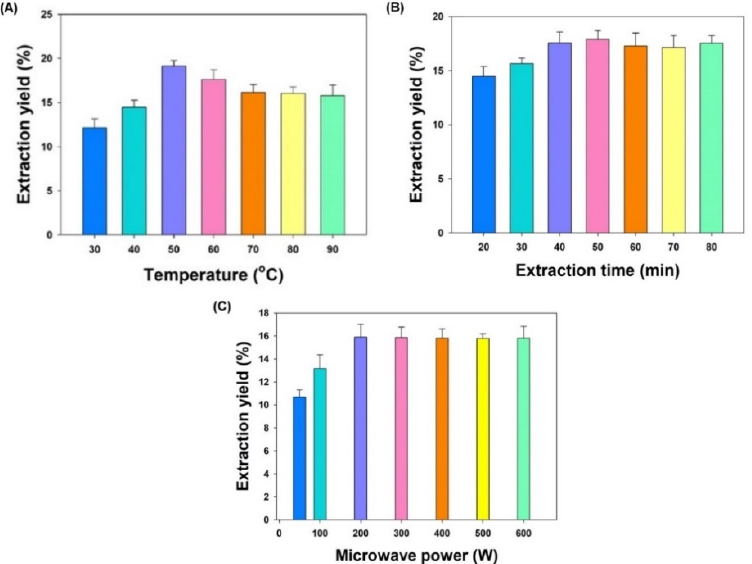
Figure 2. The effects of single factors on the total extraction yield of TCME . ( A ) Extraction temperature effect; ( B ) Extraction time effect; ( C ) Microwave power effect. Each value represents a mean ± SD ( n = 5).